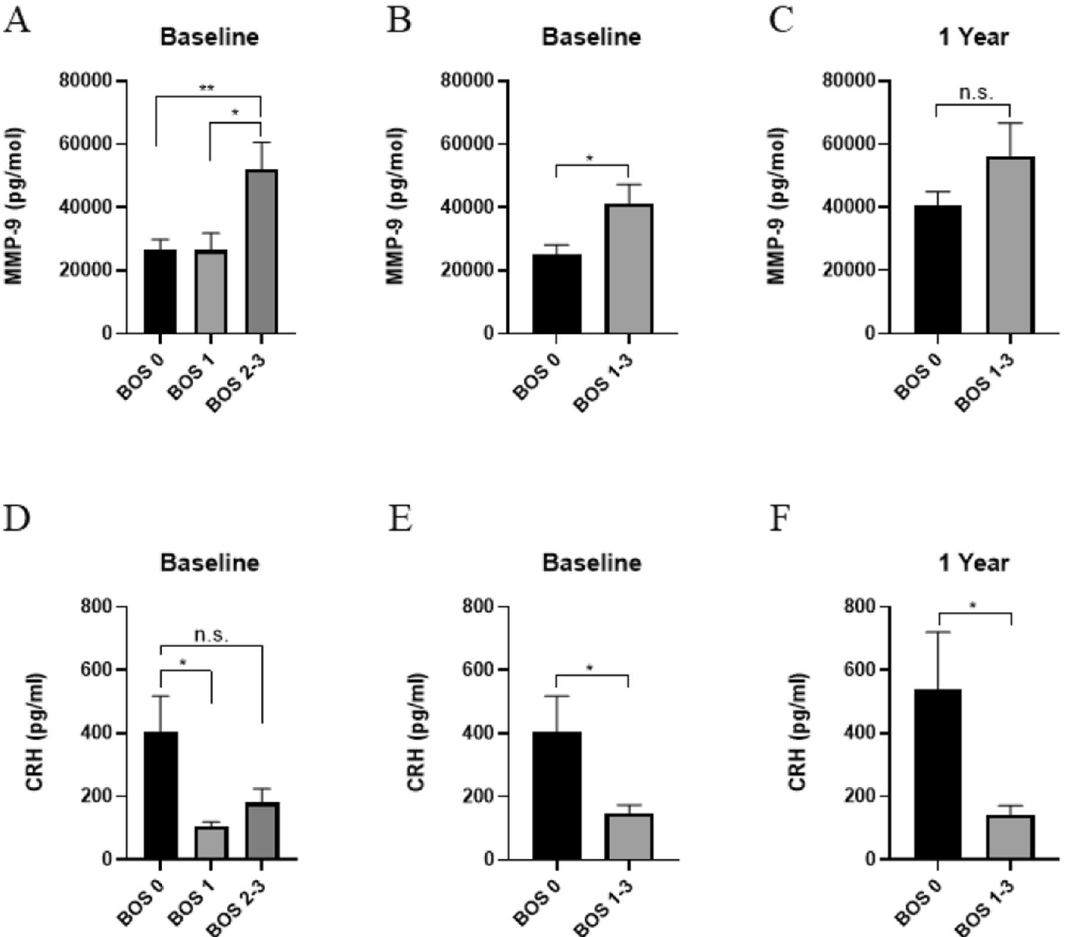
Figure 4. Expression of MMP-9 and CRH Across Timepoints. Using ELISA, MMP-9 and CRH were measured at baseline and analyzed using comparisons between BOS groups ( A , D ) or comparison of grouped BOS